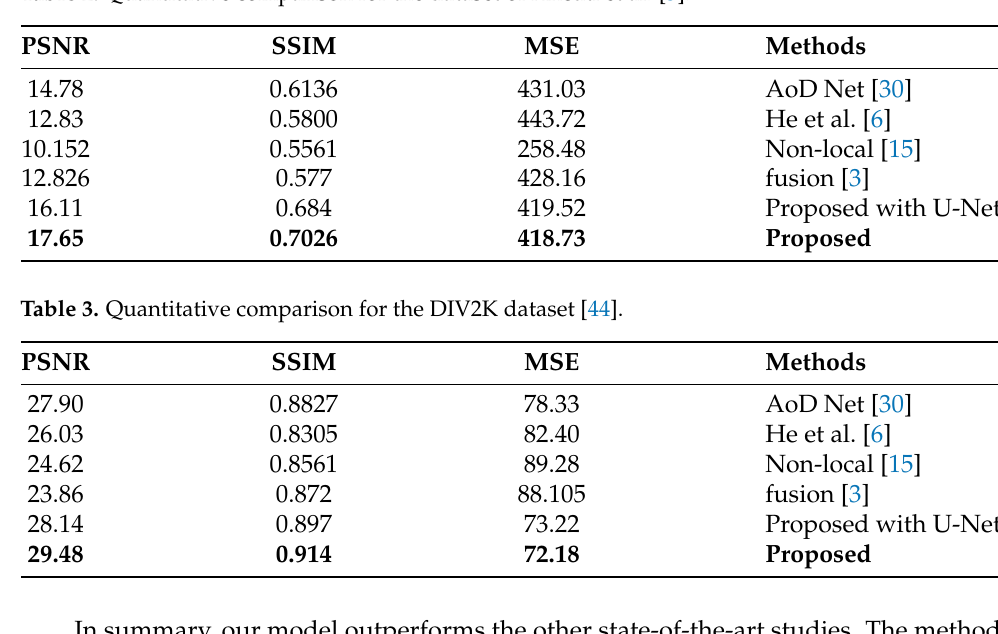
Table 2. Quantitative comparison for the dataset of Ancuti et al. [3].